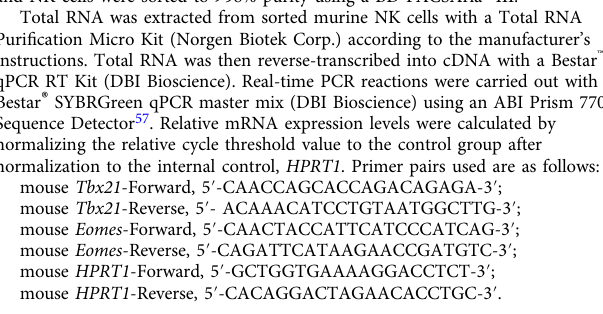
Fig. 7 Mechanisms of mTORC2 repression of mTORC1 activity in NK cells. a Intracellular fl ow cytometric analysis depicting the phosphorylation (p-) of Akt at Thr308 (p-Akt Thr308 ) in total splenic NK cells (CD3 − CD19 − NK1.1 + ). b The expression of p-S6 ser235/236 in splenic NK cells from control versus Rictor Δ / Δ mice after treatment with DMSO (set as the solvent control) or 2 μ M AKTi-1/2 for 6 h ex vivo. c The abundance of CD122 expression on splenic NK cells (CD3 − CD19 − NK1.1 + NKp46 + ) from control versus Rictor Δ / Δ mice, analyzed by fl ow cytometry. d Statistical quanti fi cation of p-STAT5 Y694 in splenic NK cells (CD3 − CD19 ― NK1.1 + ) with or without IL-15 stimulation for 4 h ex vivo. e – g , i Statistical quanti fi cation of p-S6 ser235/236 ( e ), perforin and granzyme B ( f ), frequencies of CD107a + NK cells ( g ), SLC7A5 expression ( i ) in splenic NK cells from control versus Rictor Δ / Δ mice after treatment with DMSO or 100 μ M STAT5-IN for 6 h ex vivo. h Statistical quanti fi cation of SLC7A5 expression on both total NK cells and the indicated subsets. j The expression of p- S6 ser235/236 in splenic NK cells from control versus Rictor Δ / Δ mice after treatment with DMSO or 25mM BCH for 6 h ex vivo. The MFI was relative to the littermates of control + DMSO group ( b , e , f , i , j ). Each dot represents one mouse, and all experiments were replicated 3 ( a , b , e – j ), 5 ( d ), 6 ( c ) times;